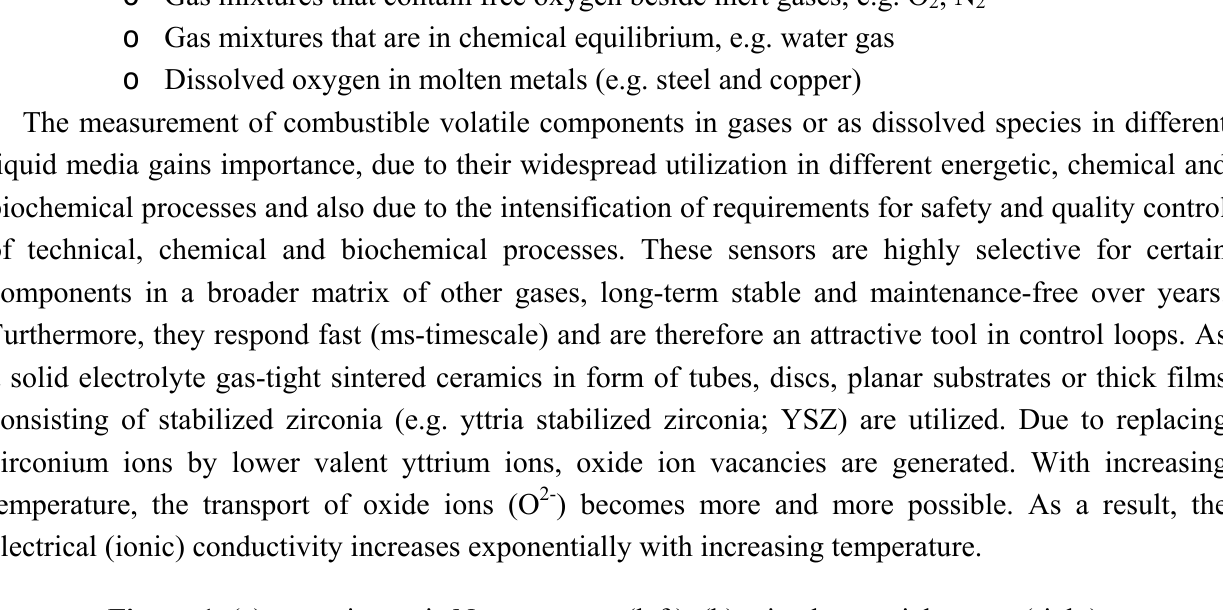
Figure 1. (a) potentiometric Nernst sensor (left). (b) mixed potential sensor (right).